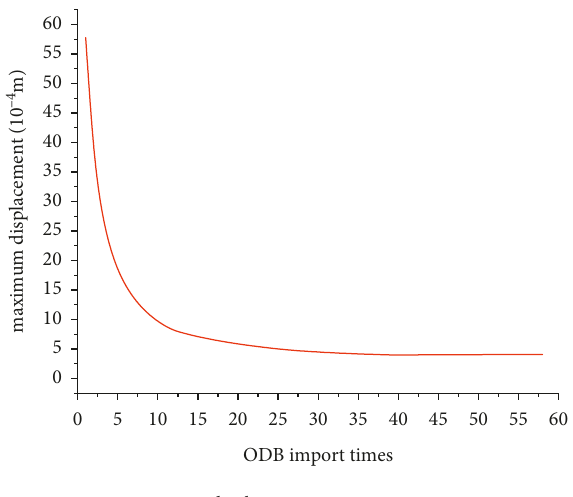
Figure 4: Import times-maximum displacement curve.